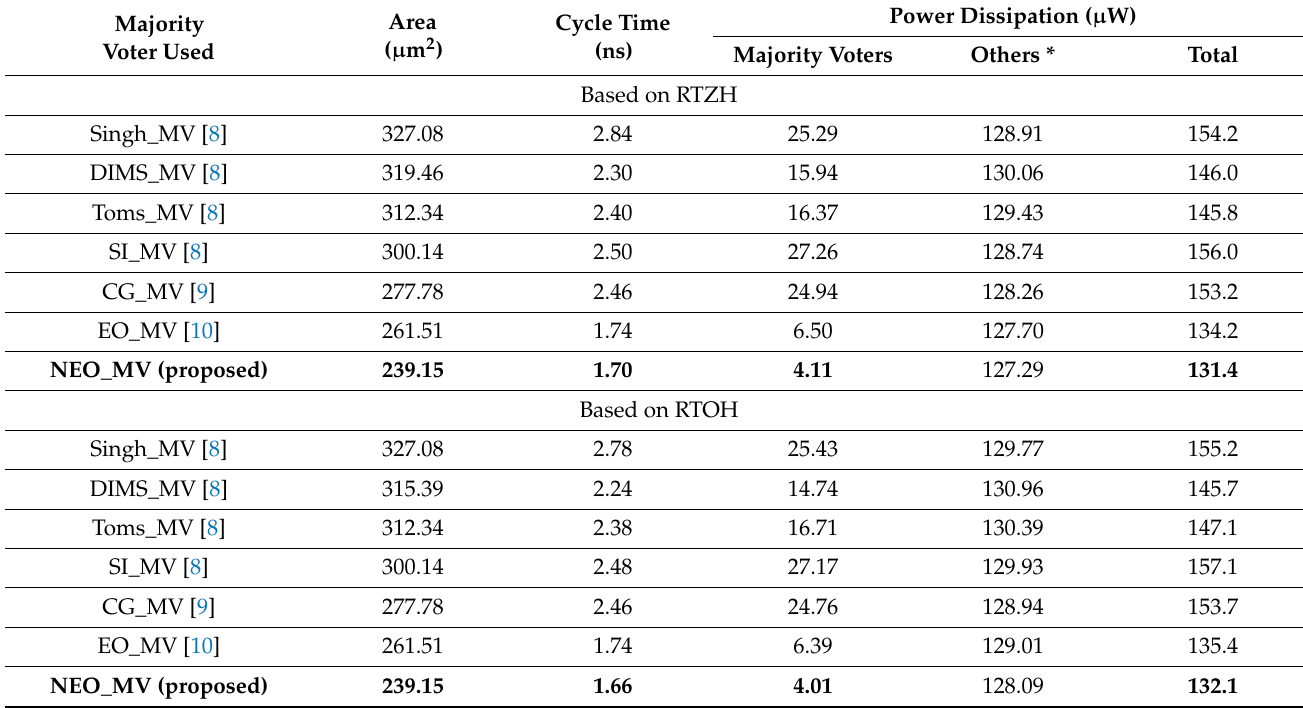
Table 3. Design metrics of asynchronous TMR implementations with respect to RTZH and RTOH.